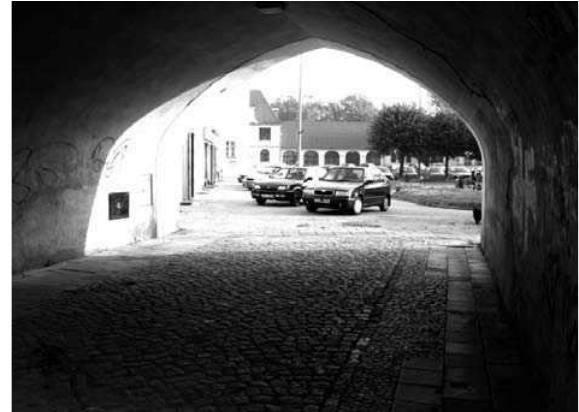
Fig. 8. Actual view of market square in karłowice (since 1928 settlement of Wrocław town)